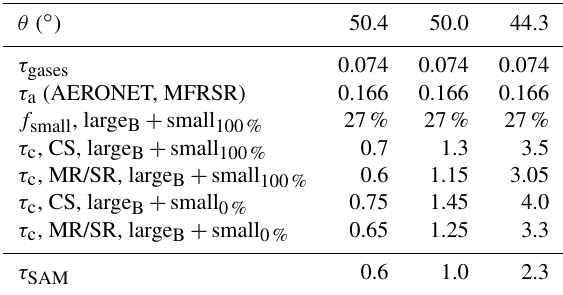
Table 5. The values of solar zenith angle θ and optical thickness of cloud ( τ c ), aerosol ( τ a ), and gases ( τ gases ) used in the compari- son simulations for flight B. The cloud is described with the size- shape distributions large B and large B + smal l 100% of rough (MR and SR) and completely smooth (CS) ice crystals. The fractional contribution of small ice crystals to cloud optical thickness for the large B + small 100% size-shape distribution ( f small ) and the total op- tical thickness (cloud + aerosols) retrieved from the Sun and Aure- ole Measurements (SAM) instrument are also